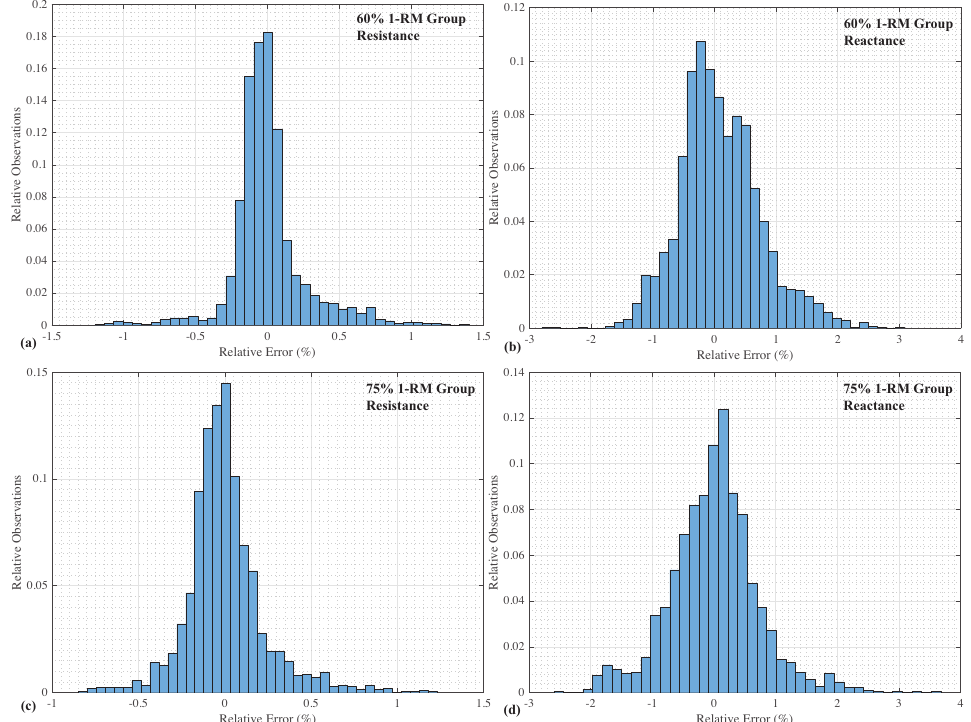
Figure 4. Relative error distributions of simulated impedances using Cole-impedance parameters compared to experimental values for ( a ) resistance and ( b ) reactance of the 60% 1-RM group; and ( c ) resistance and ( d ) reactance of the 75% 1-RM group (using all right/left and pre/post-fatigue